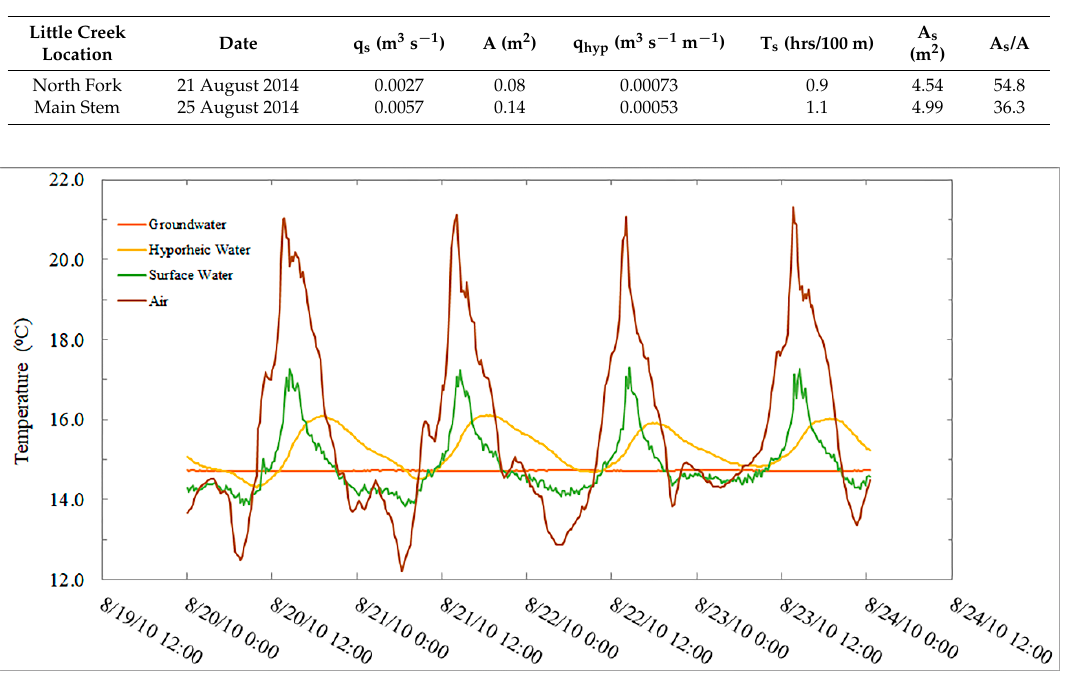
Table 2. Streamflow (q s ), hyporheic exchange rate (q hyp ), residence time (T s ) (hrs/100 m), subsurface cross section area (A s ) determined from rhodamine dye injection analysis. Stream cross-section is the average of channel measurements (A).